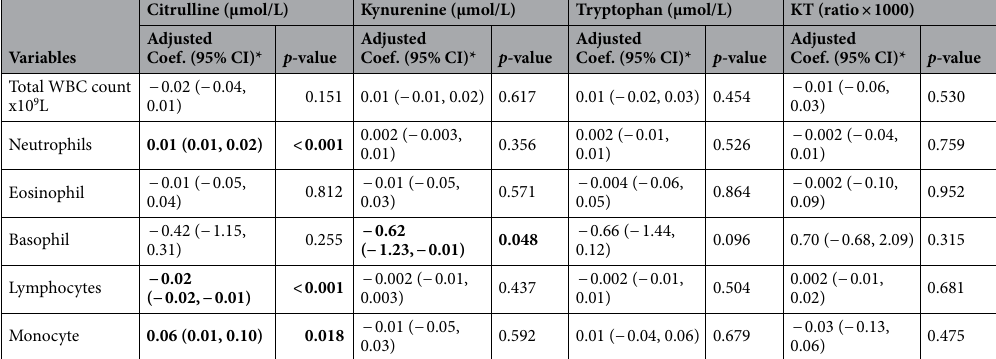
Table 4. Concurrent predictors associated with citrulline, kynurenine, and tryptophan concentrations and the KT ratio at baseline with blood leukocyte concentrations (lymphocytes, monocytes, neutrophils, eosinophils, and basophils) as a marker of systemic inflammation. Coef.: coefficient; 95% CI: 95% confidence interval; *Models adjusted for age at enrollment. Values represent the beta coefficient and 95% CI from linear regression models. For continuous predictors, this represents the change in outcome corresponding to a one- unit increase in the predictor.